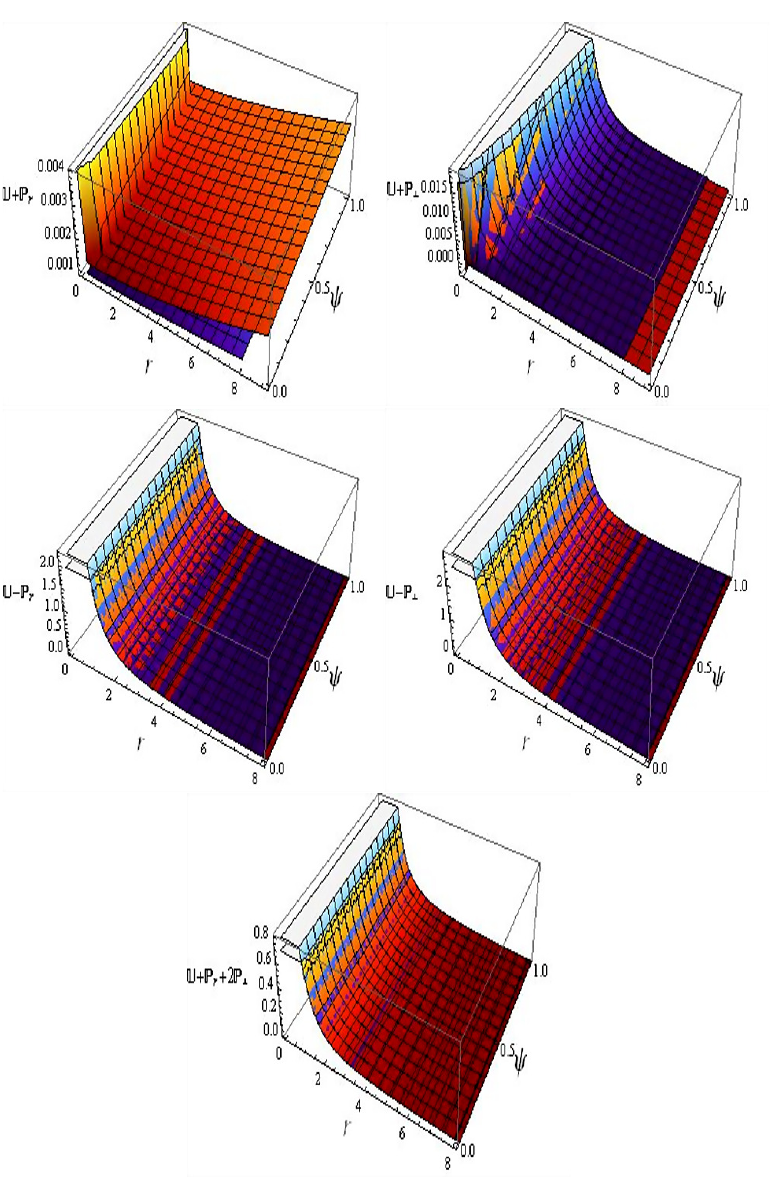
Figure 2. Plots of energy constraints versus ψ and r corresponding to two stellar candidates (Solution